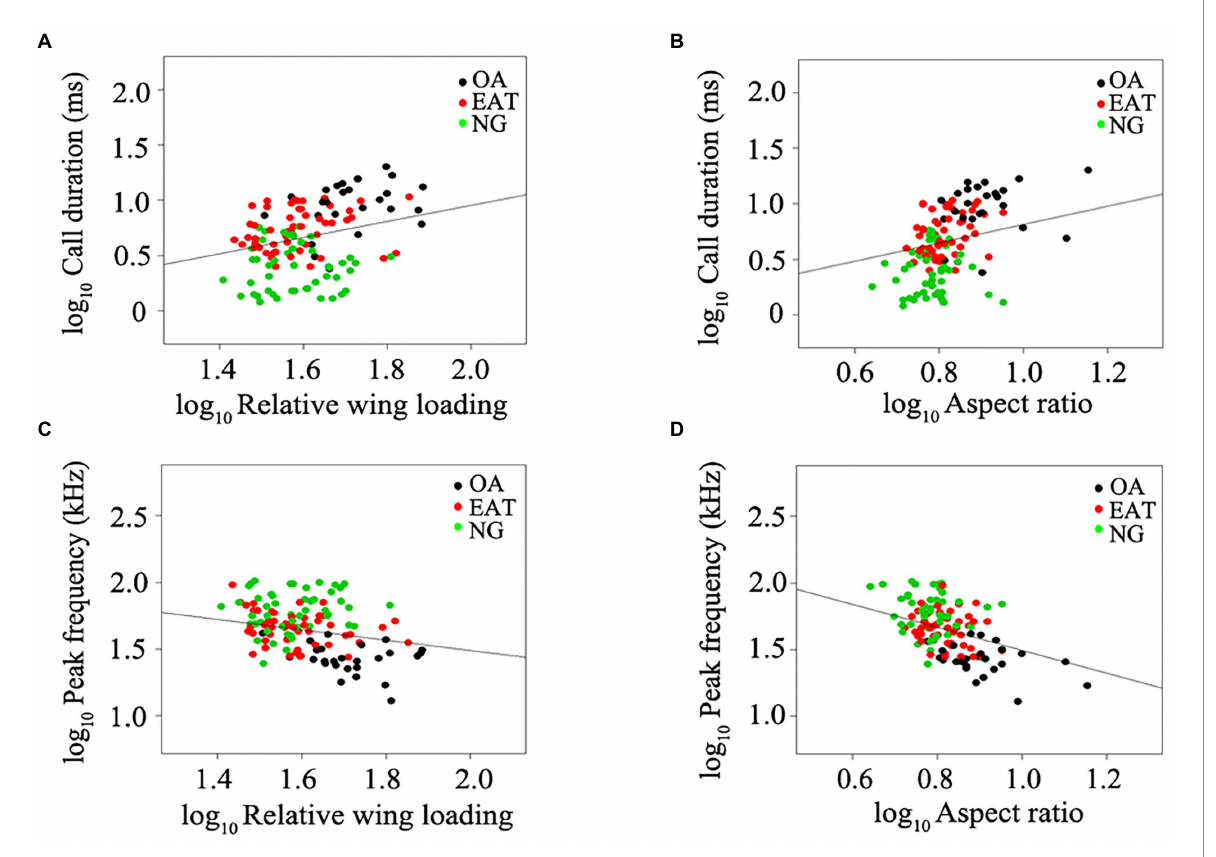
FIGURE 2 Relationship between wing morphology and echolocation call parameters in bats excluding narrow-space flutter-detecting foragers. (A) Relative wing loading and call duration. (B) Aspect ratio and call duration. (C) Relative wing loading and SCPF. (D) Aspect ratio and SCPF. Black plots represent open-space aerial forager (OA). Red plots represent edge-space aerial and trawling forager (EAT). Green plots represent narrow-space gleaning forager (NG). Lines represent the best-fitting regression models after correcting for